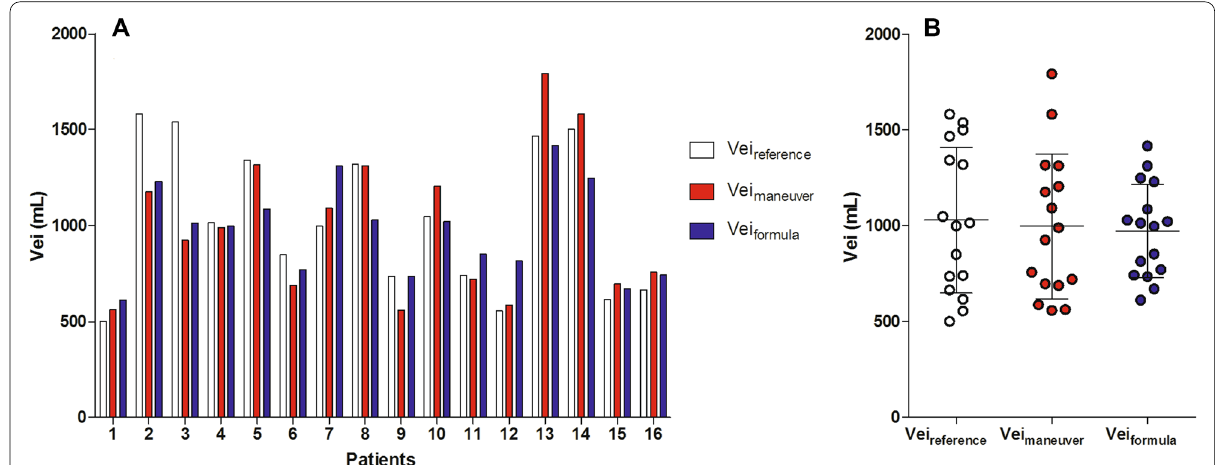
Fig. 4 Individual ( A ) and mean SD ( B ) data of the different bedside techniques to quantify dynamic pulmonary hyperinflation ±